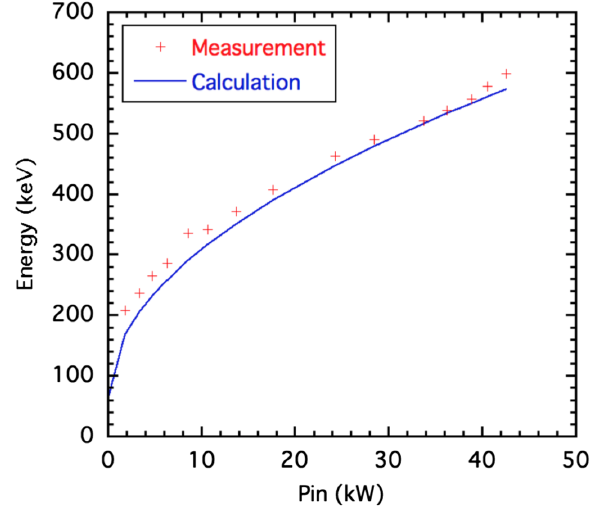
given by the blue solid line using the measured shunt impedance of 6 . 17 M Ω .